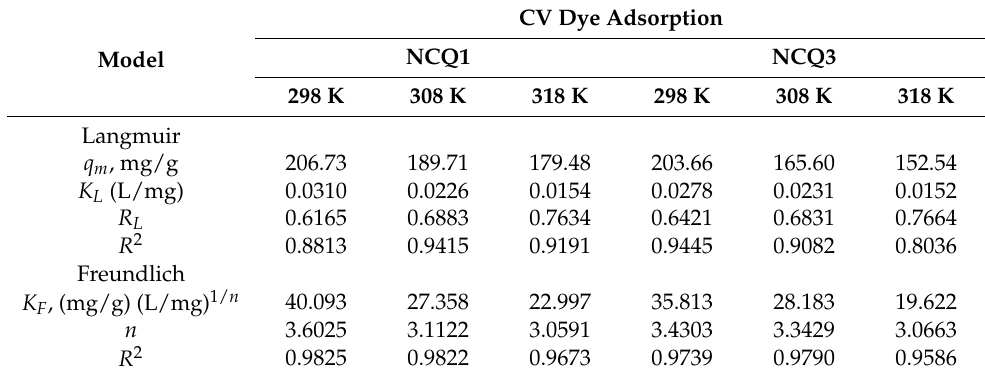
Table 4. Nonlinear isotherms models for CV dye adsorption on both NCQ1 and NCQ3 adsorbents.